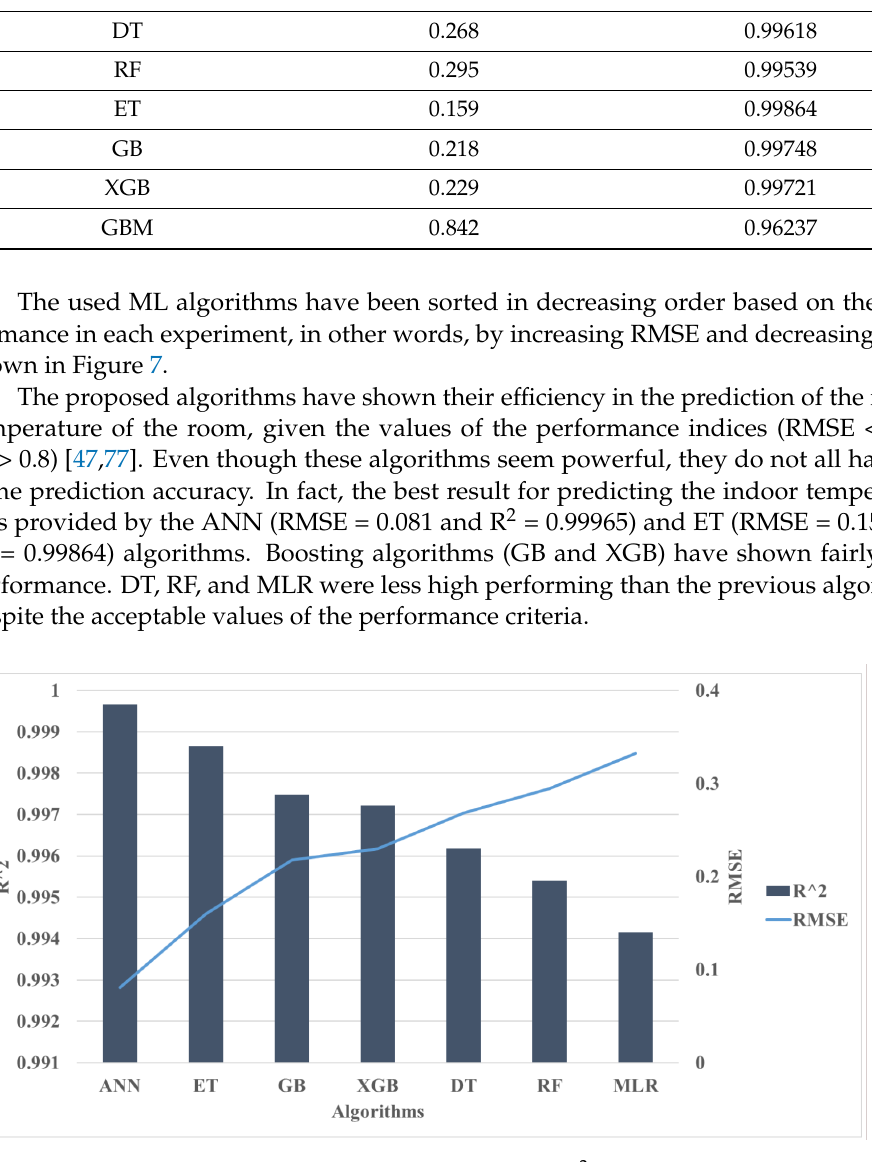
Figure 7. Performance criteria of ML algorithms (RMSE and R 2